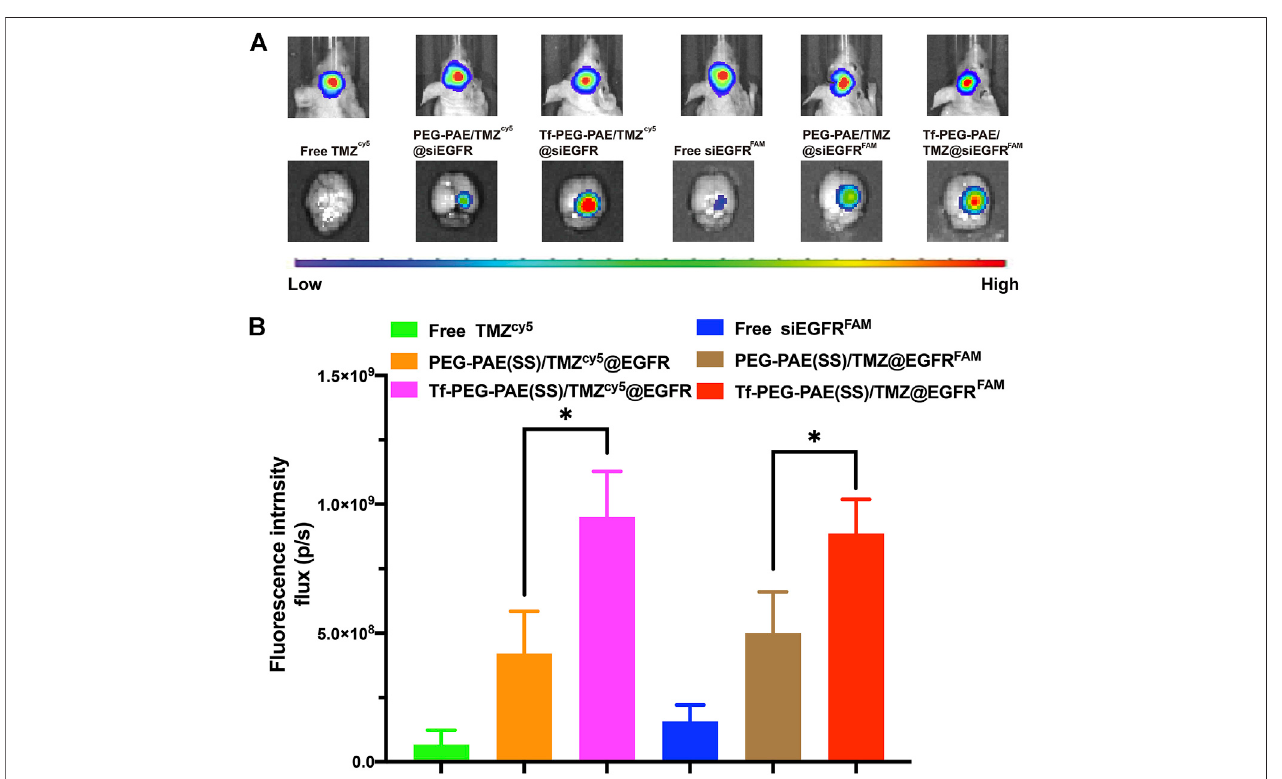
FIGURE8| DistributionofTMZandsiEGFRinglioma. (A) Bio fl uorescenceimagingofgliomaswiththesimilarsize,4 hafterintravenousinjectionofmicewitheither free TMZ cy5 , free siEGFR FAM , PEG-PAE(SS)/TMZ cy5 @siEGFR, PEG-PAE(SS)/TMZ@siEGFR FAM , Tf-PEG-PAE(SS)/TMZ cy5 @siEGFR, and Tf-PEG-PAE(SS)/TMZ@ siEGFR FAM . (B) Quantitative analysis of TMZ and siEGFR fl uorescence intensity in glioma. (Mean ± SD, n = 3) and p p < 0.05.